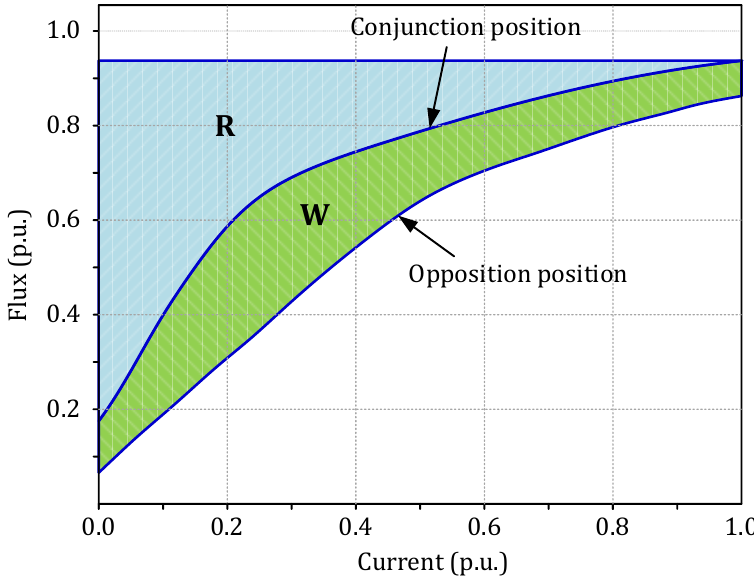
Figure 6. Flux linkage versus stator phase